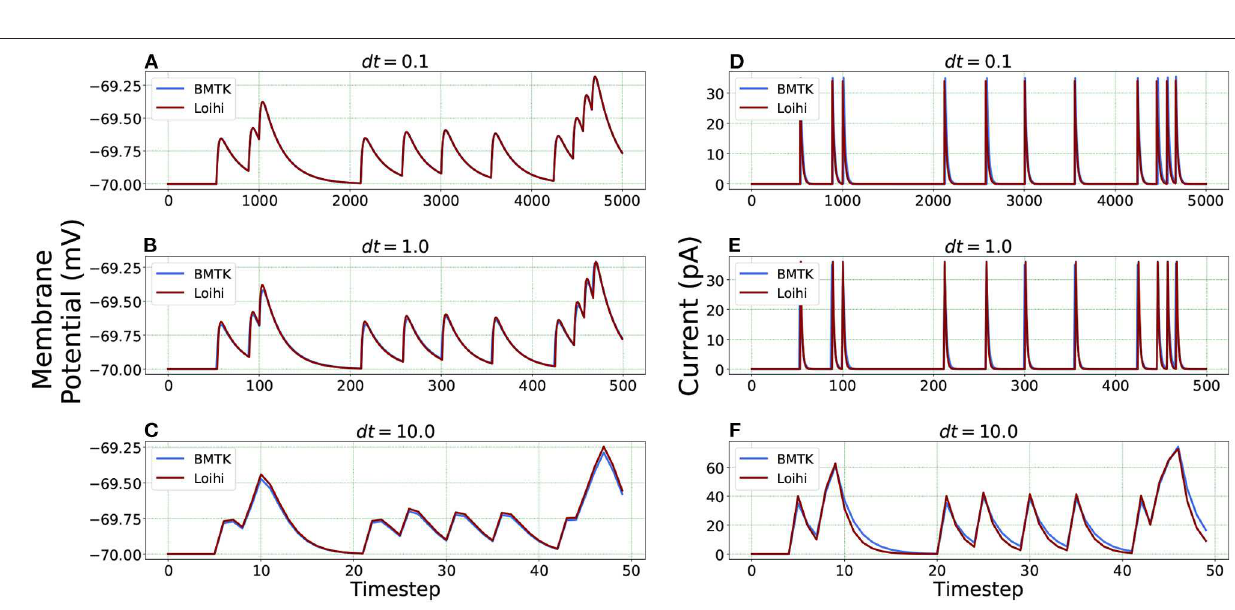
FIGURE 6 | Comparison of membrane potential and current plots with different temporal precisions in Loihi. Membrane potential plots are on the left with (A) dt = 0.1 (B) dt = 1.0 (C) dt = 10.0. Current plots are on the right with (D) dt = 0.1 (E) dt = 1.0 (F) dt = 10.0. For dt = 10.0, number of time-steps are 50 and for dt = 0.1, number of time-steps are